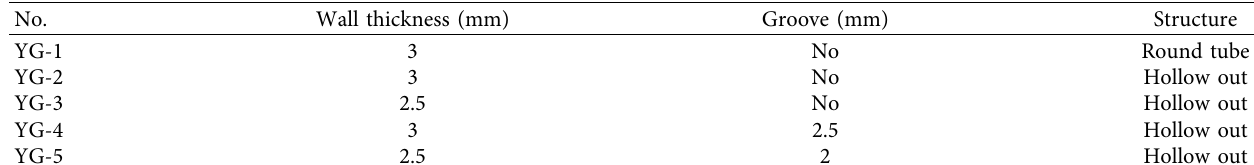
Figure 1: Three structural schemes of thin-walled round tube crushing components. Table 1: Schemes of thin-walled energy-absorbing components.